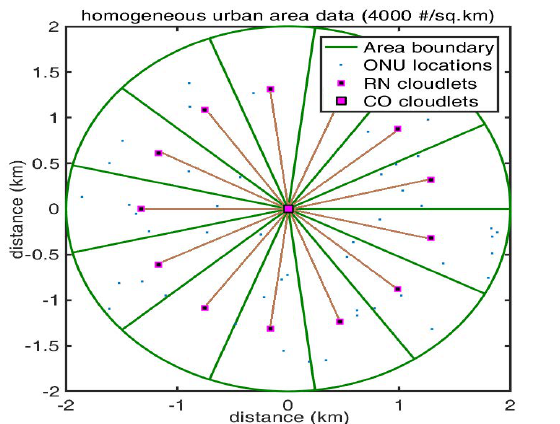
Figure 3. An example homogeneous network with ONU locations (blue dots), RN locations (black squares), and CO locations (pink squares) with split-ratio 1:8 over an urban population area with 4000 people/km 2 (only the feeder fibers are